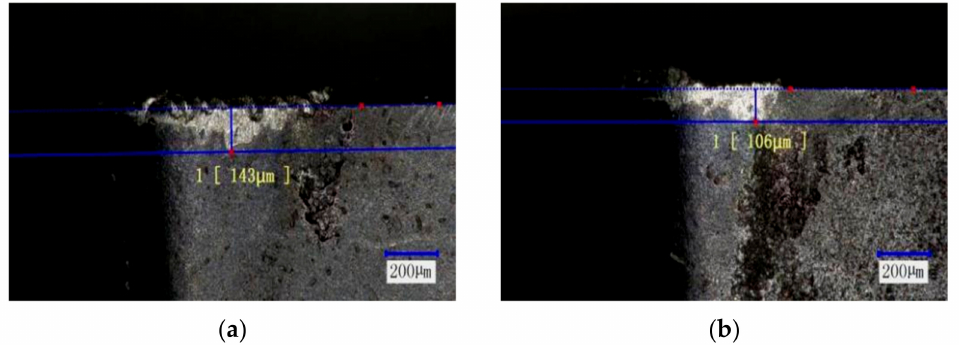
Figure 8. The VBmax value in both conventional machining and laser-assisted machining (v c = 50 m/min, f = 0.10 mm/rev and ap = 0.5 mm): ( a ) CM-2; ( b )